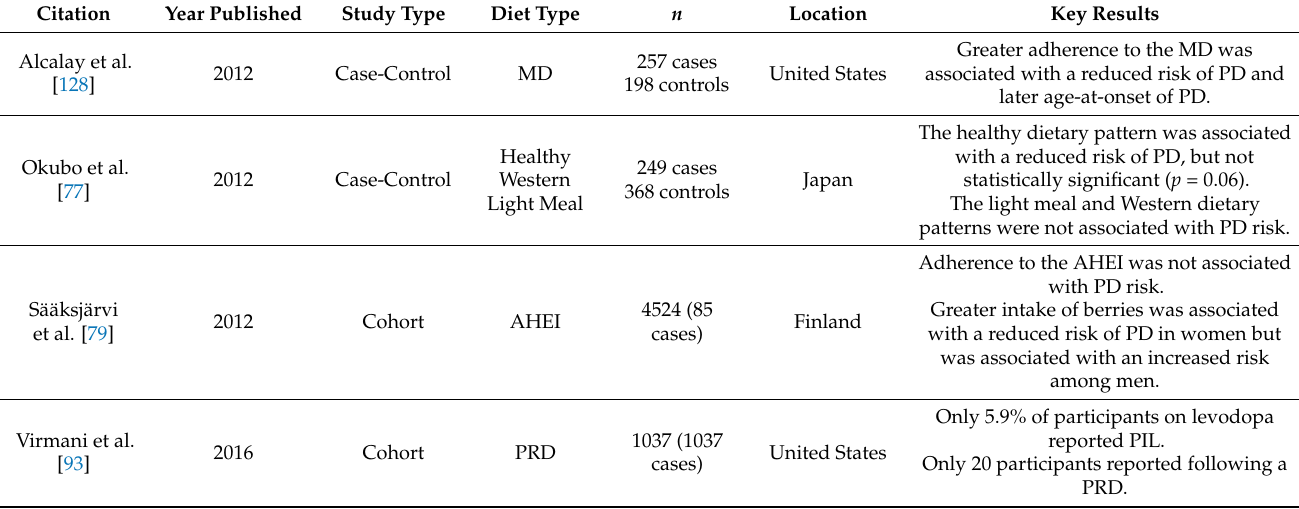
Table 1. Summary of Observational Study Results on the Impact of Diet and Dietary Patterns on